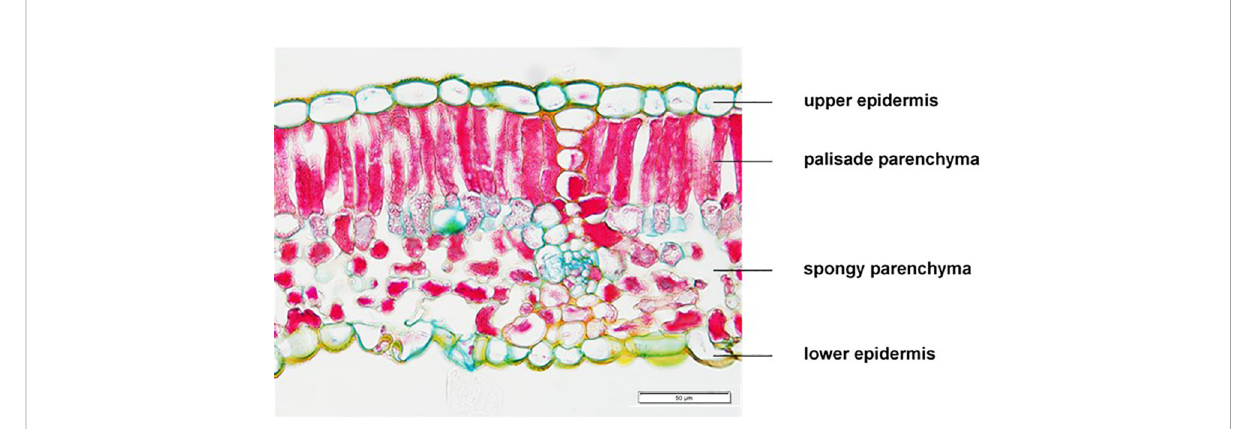
FIGURE 1 Histological tissue section of a Vitis vinifera cv. Riesling leaf as basis for analysis of epidermal and parenchymatic